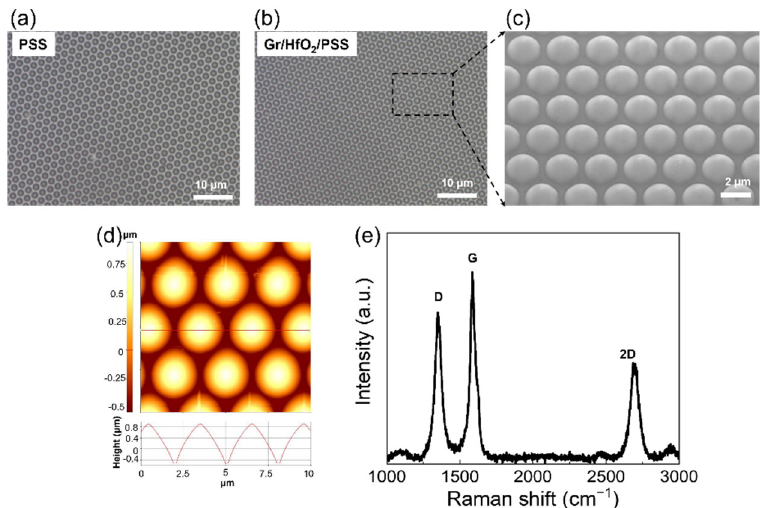
Figure 2. Surface analysis of 3D Gr on HfO 2 /PSS. Optical microscopy images of ( a ) PSS and ( b ) Gr/HfO 2 /PSS. ( c ) SEM image, ( d ) AFM image, and ( e ) Raman spectrum of 3D Gr on HfO 2